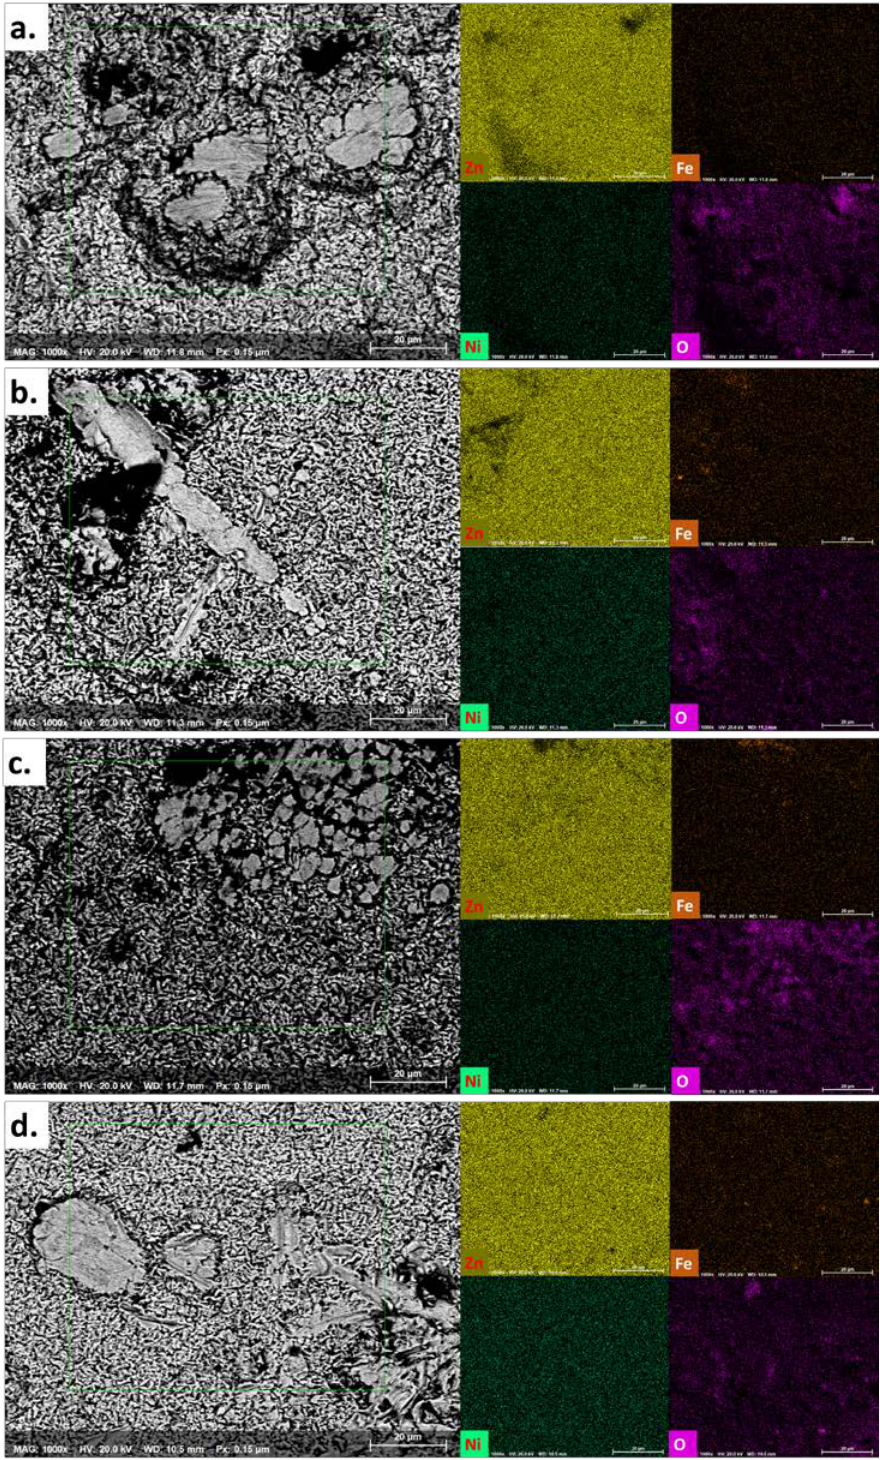
Figure 5. Surface topography of the Zn-Ni alloy coatings showing the distribution of Zn, Ni, Fe and O elements in the microstructure of ( a ) Zn-Ni-10, ( b ) Zn-Ni-15 ( c ) Zn-Ni-20 and ( d ) Zn-Ni-25 coat- ings.